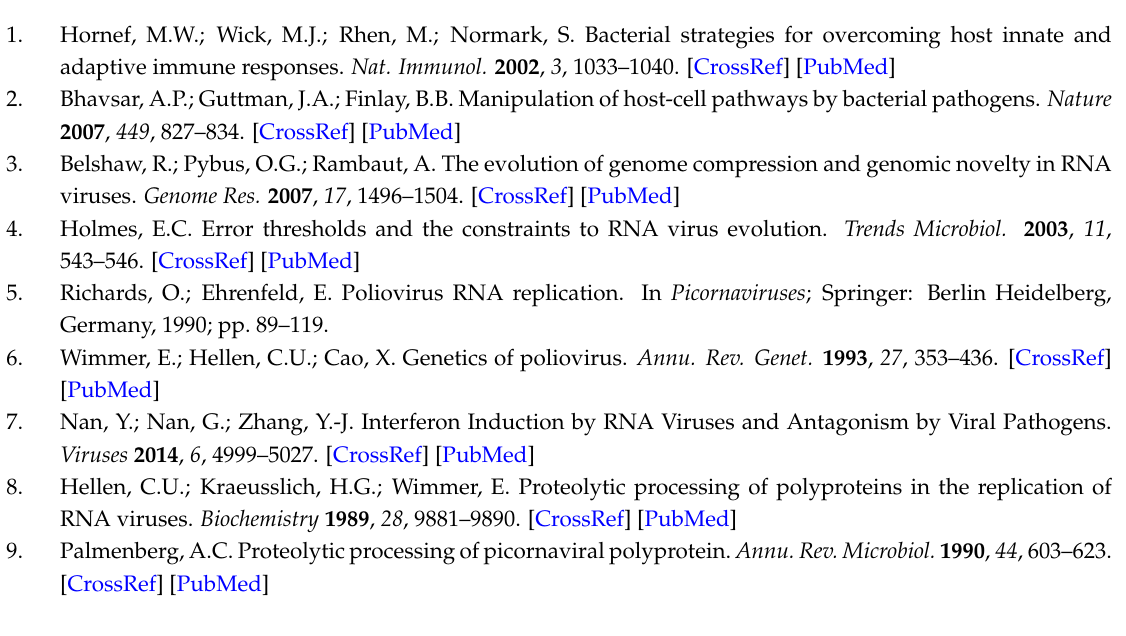
Figure S1: DLS analysis of PV 3CD protein, Figure S2: PCA analysis reveal major motions of 3CD, Figure S3: MD simulations reveal multiple interfaces in WT and mutant 3CD, Figure S4: Mutations of 3CD in the crystal structure, Figure S5: Analysis of the 50 ns MD simulations of mutant PV 3CD, and Video S1: Conformational Ensemble of the Poliovirus 3CD Precursor Observed by MD Simulations and Confirmed by SAXS: A Strategy to Expand the Viral Proteome?; DOI: